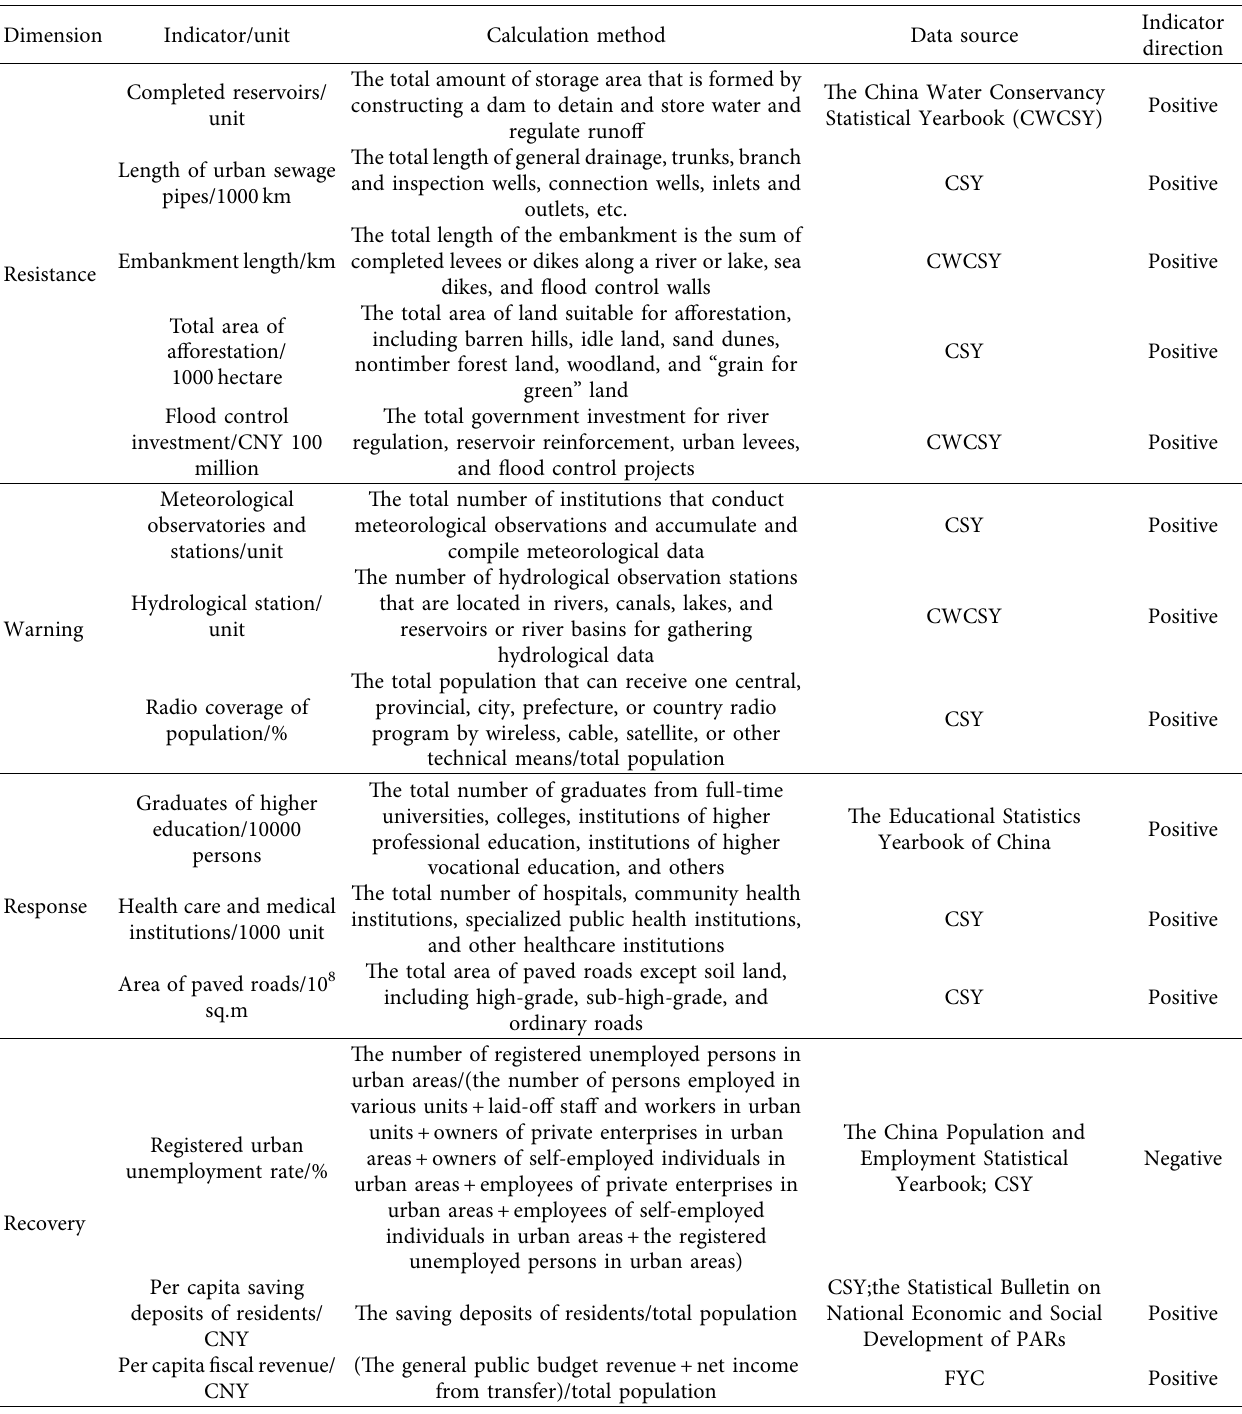
Table 2: EIS of FR as a mediating